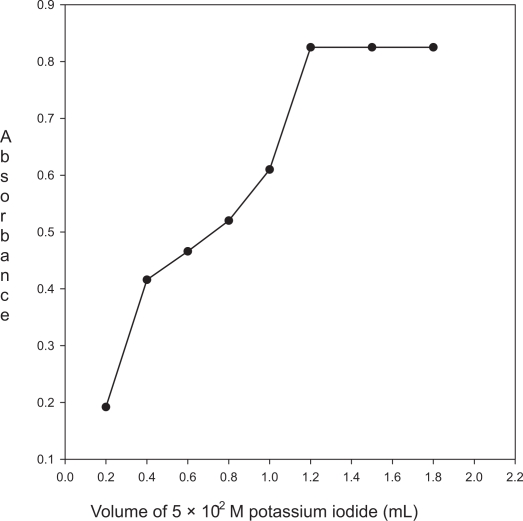
Effect of the volume of 5.0 × 10−2 M potassium iodide on the absorbance of the product (enalapril maleate 50 μg mL−1; 1.0 mL of 3.0 × 10−3 KIO3).